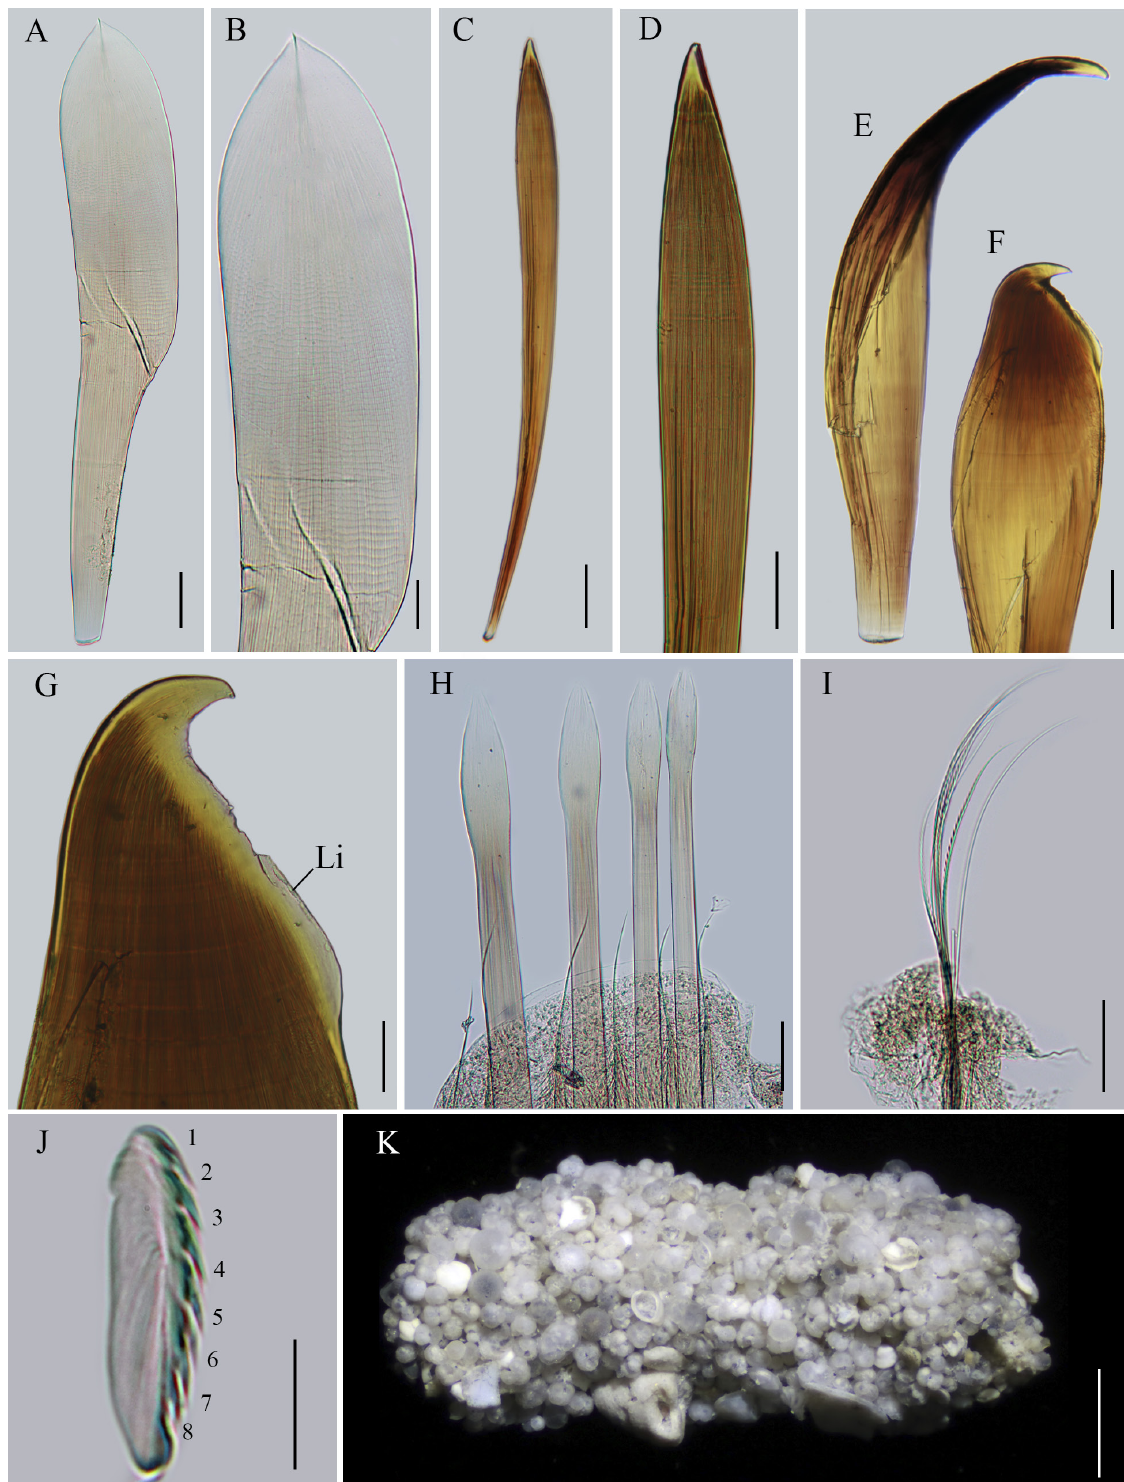
Fig. 21. Tetreres oscari sp. nov., holotype (UMML-22.1197). A–B . Outer palea. C-D . Inner palea. E . Nuchal hook, lateral view. F . Nuchal hook, ventral view. G . Tip of nuchal hook. H . Parathoracic notochaetae. I . Abdominal parapodium. J . Uncini. K . Tube. Abbreviation: Li = limbation. Numbers indicate the rows of teeth. Scale bars: A, D, G–I = 100 µm; B = 50 µm; C, E–F = 200 µm; J = 20 µm; K = 2